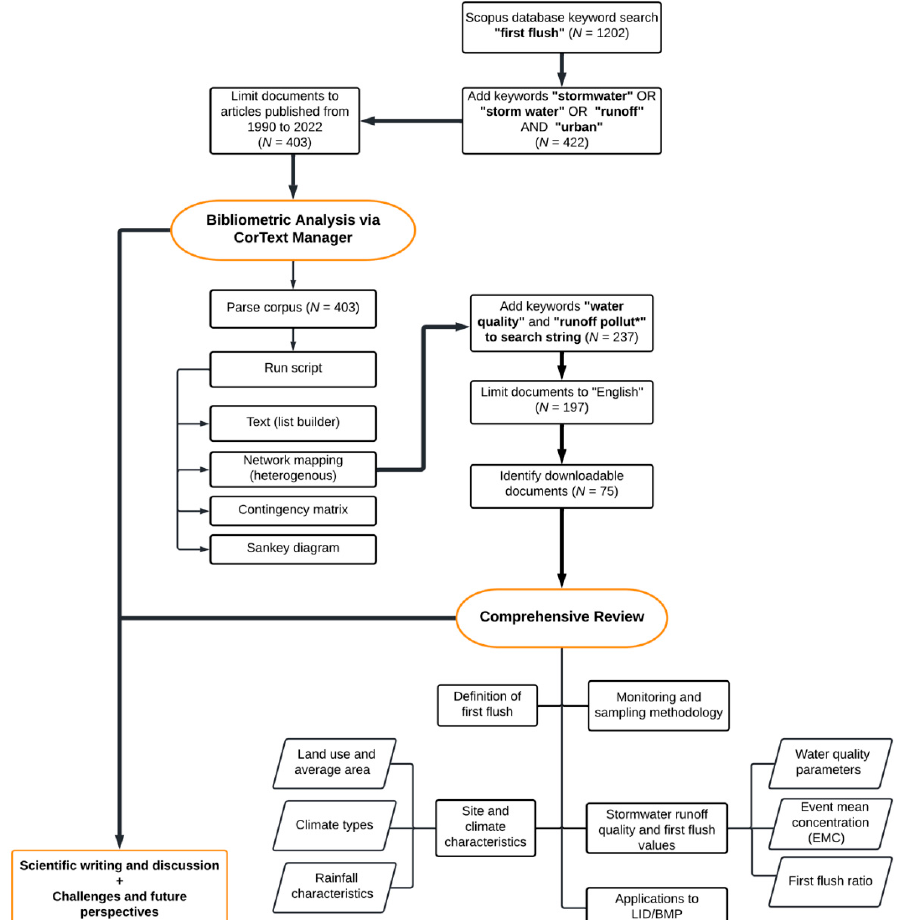
Figure 1. Framework of the review methodology.